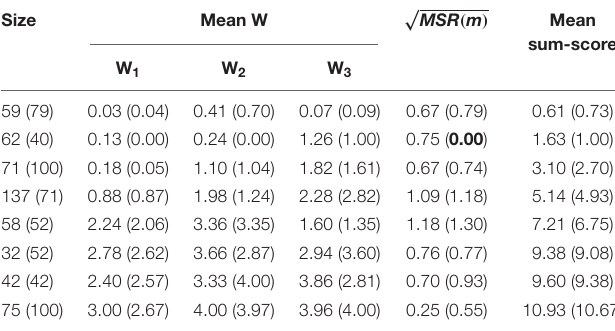
TABLE 4 | Classification by SCA-Ward’s and K-means-Ward’s algorithm.